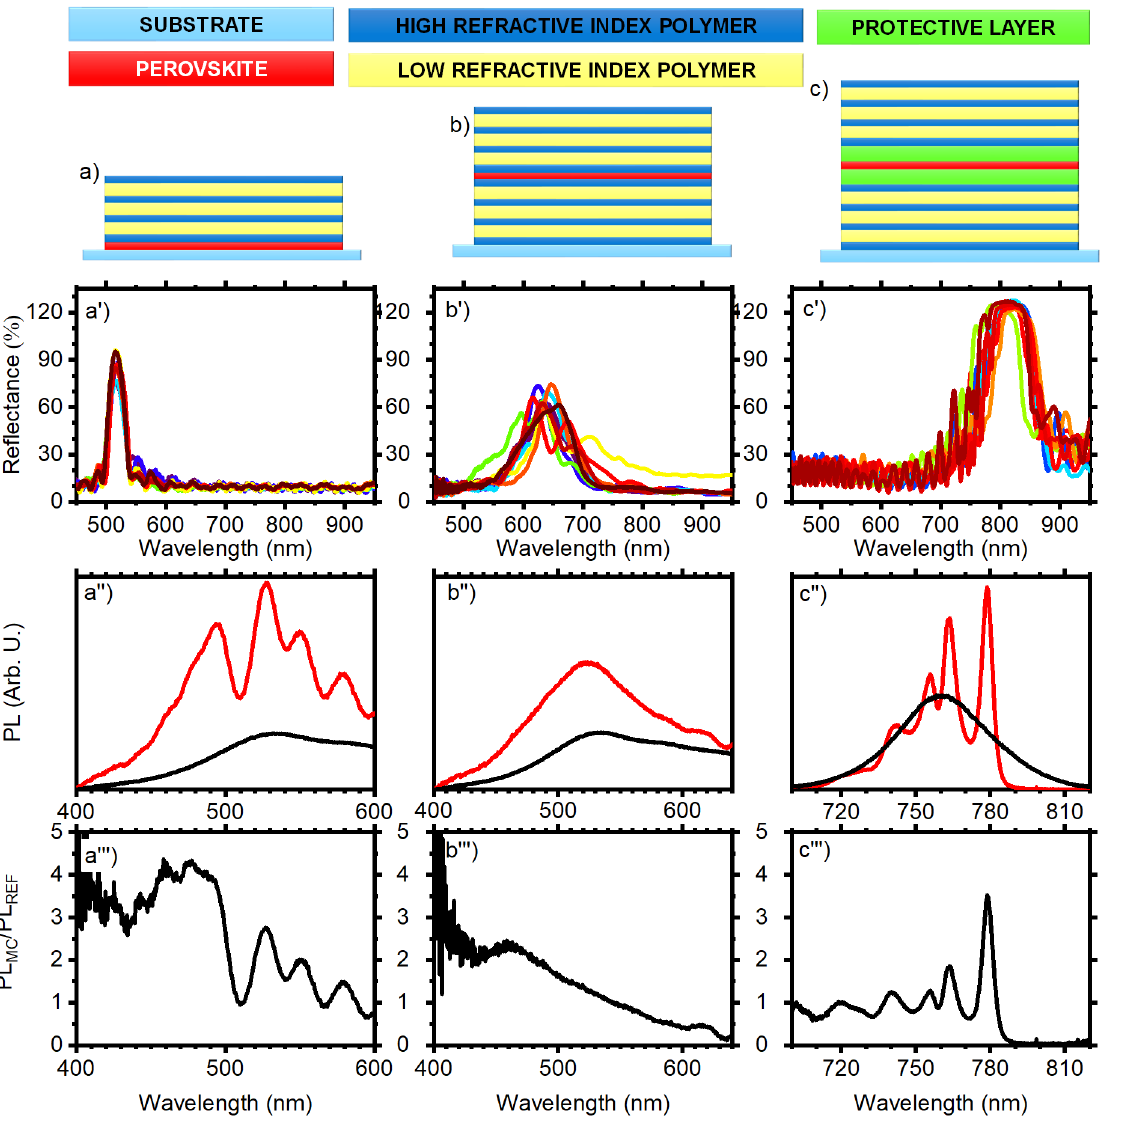
Fig. 1. Schematic (a, b, c) reflectance spectra (a’, b’, c’) photoluminescence spectra of the photonic structure (red line) and of the reference film (black line) (a’’, b’’, c’’), and ratio spectra calculated normalizing the photonic structure emission by the reference emission (a’’’, b’’’ c’’) for the three architectures: (EDBE) PbCl 4 coupled with a DBR[8] (panels a) and with a full microcavity (panels b) and MA PbCl 4 embedded in a microcavity employing a protective layer.[27]